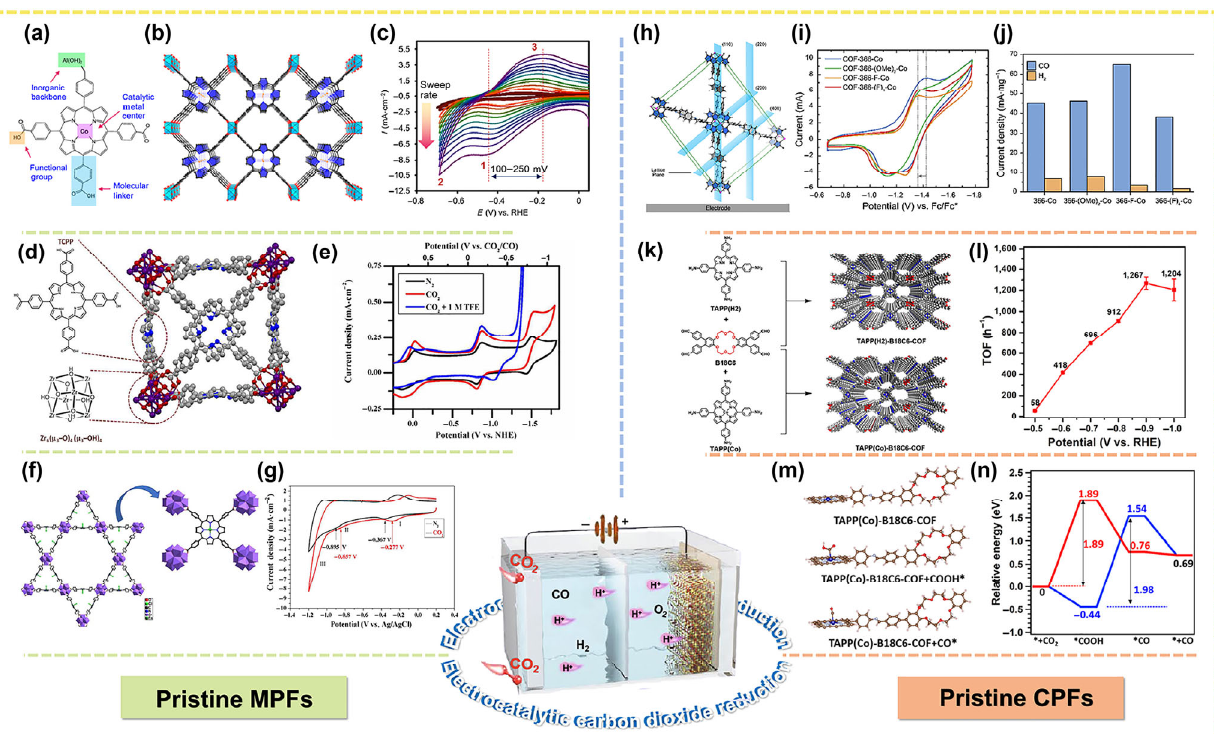
(Fig. 2(d)). CVs of homogeneous Fe-TPP in dimethyl formamide (DMF) at a scan rate of 0.1 V·s −1 are shown in Fig. 2(e). The